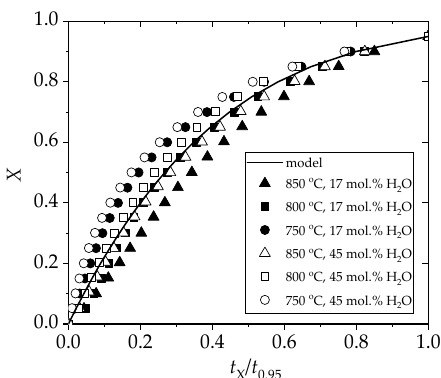
Figure 6. Comparison of the conversions obtained from Equation (4), and measured in this work for the structural parameter.